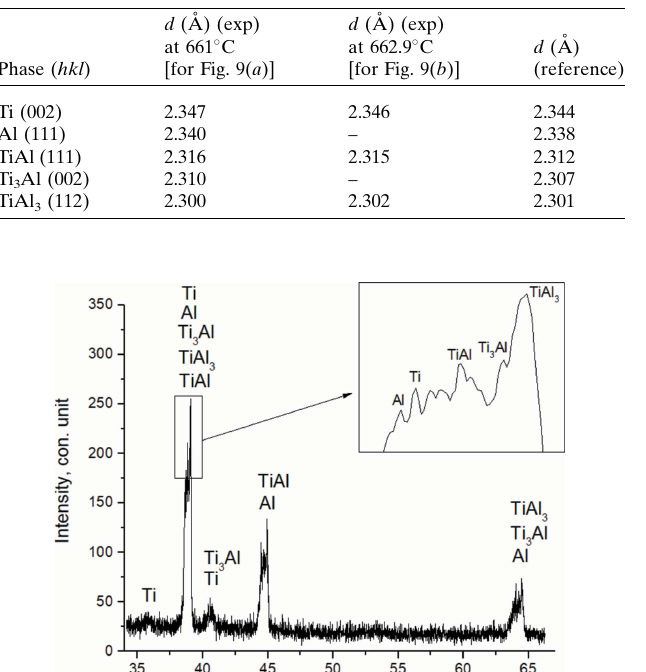
Table 4 Interplanar phase distances for diffractograms in Fig. 10.